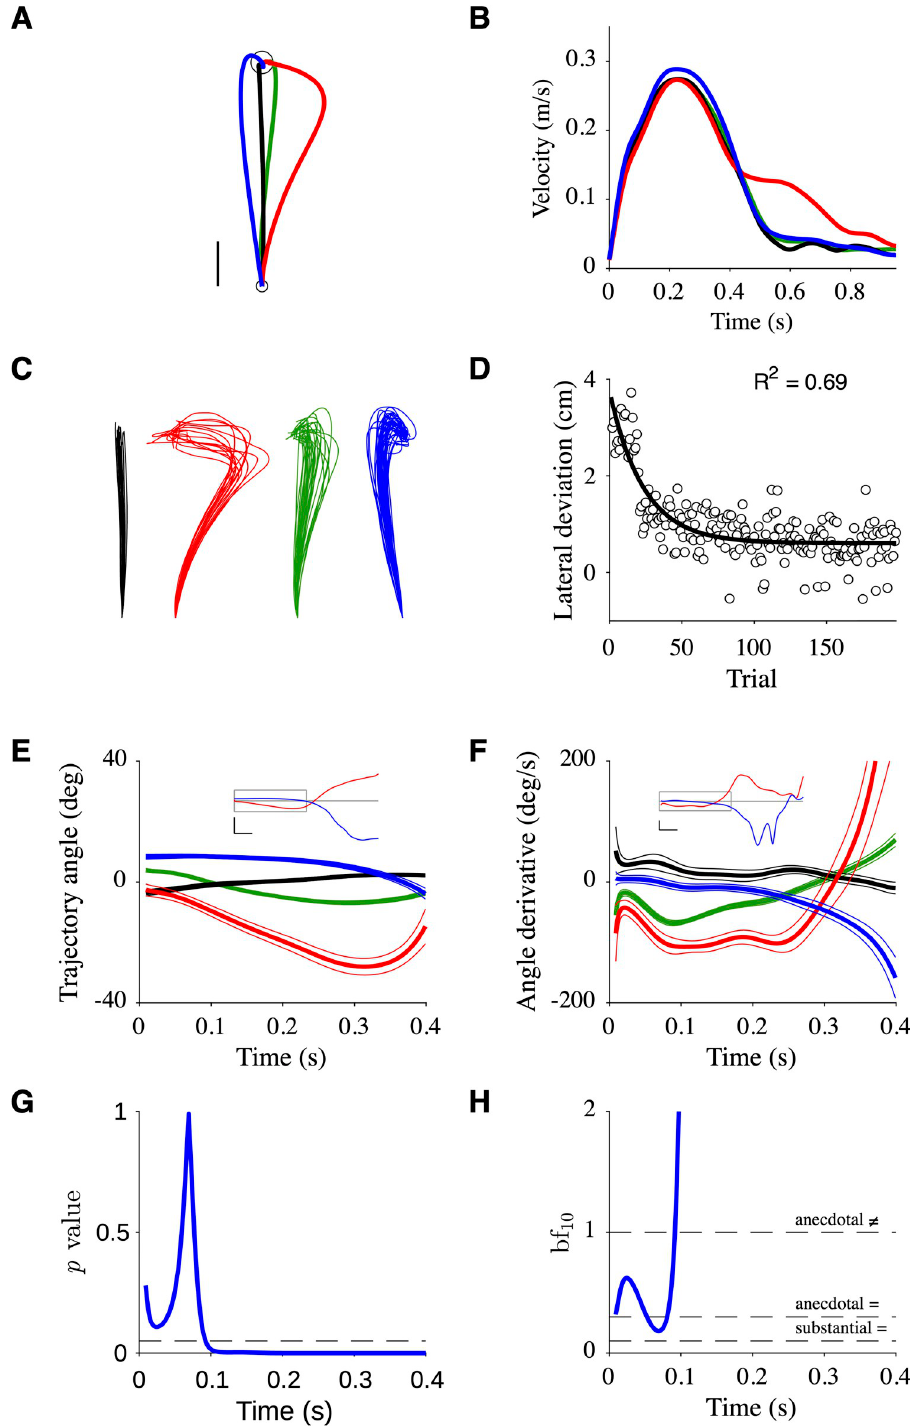
Fig 5. Data of participant P7. A . Mean trajectories. Scale: 0.02 m. B . Mean velocity profiles. C . Single trials (17, 19, 107, 34 trials, from left to right). Same scale as in A . D . Changes in lateral deviation (maximum of trajectory deviation from the start position/target position line) with training. The data were taken from C ( red and green ). Fitting an exponential decay is shown. E . Mean trajectory angle over the first 0.4 s with the 95% confidence interval. Inset: mean trajectory angle over the first 0.8 s; the box indicates the 0–0.4 s window. Scale: 0.1 s, 60 deg. F . Same as E for mean trajectory angle derivative. Scale: 0.1 s, 200 deg/s. G . p -value of a test 6¼ 0 vs = 0 for trajectory angle derivative in F .